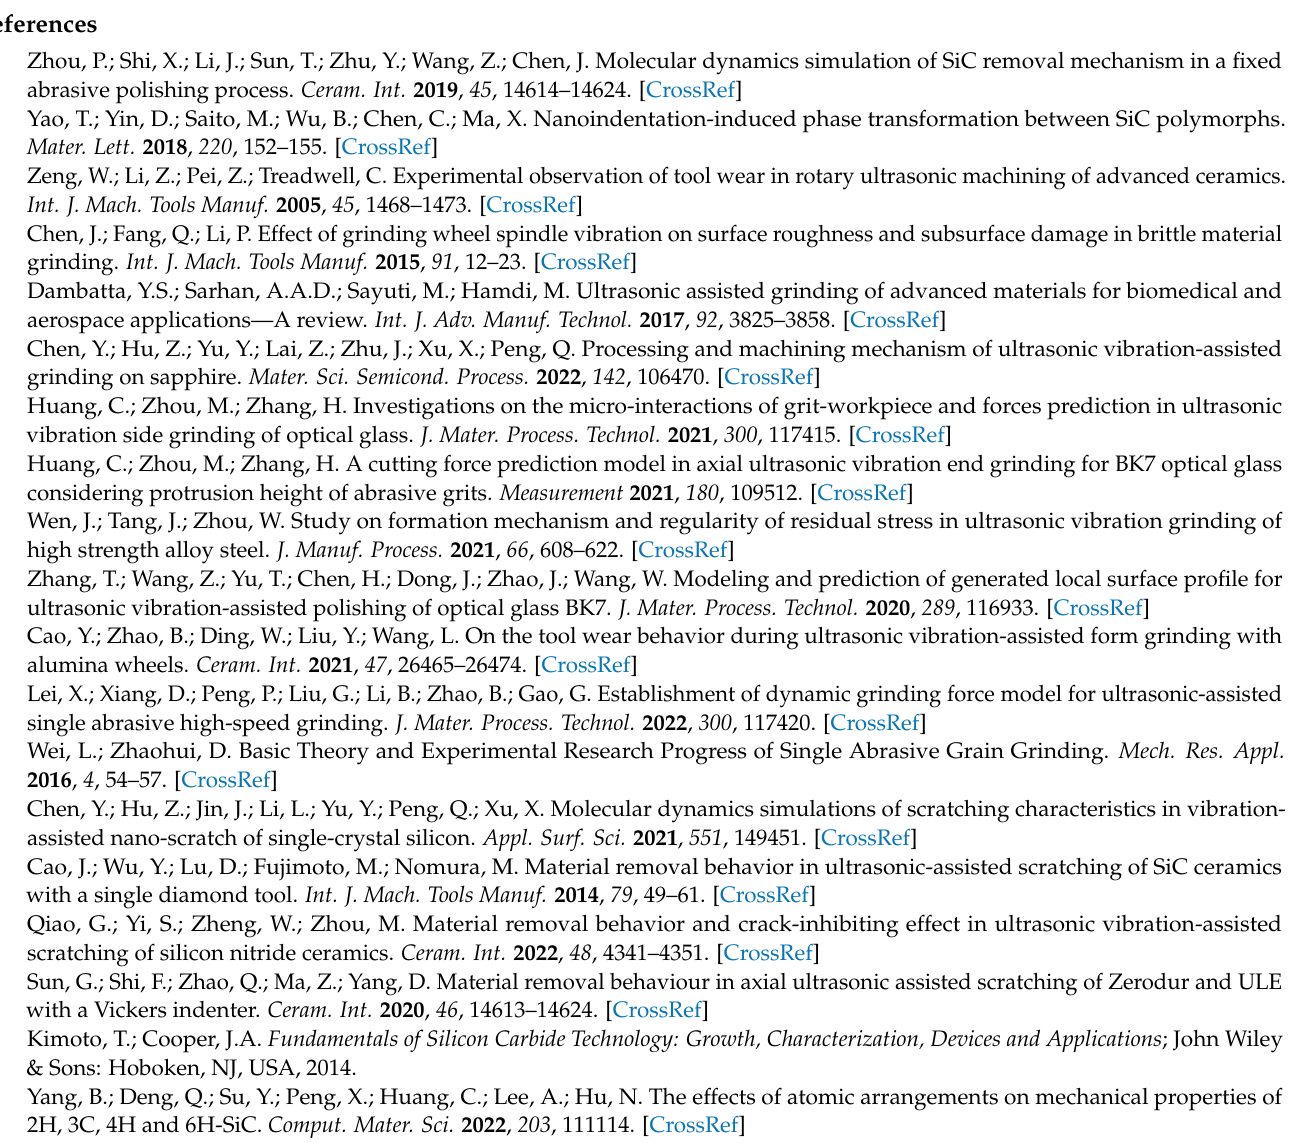
Figure S4: Variation of scratch force of SiC polytypes with different depths: (a) Si-face and (b) C-face of SiC. Figure S5: Variation of scratch force of SiC polytypes with different speeds: (a) Si-face and (b) C-face of